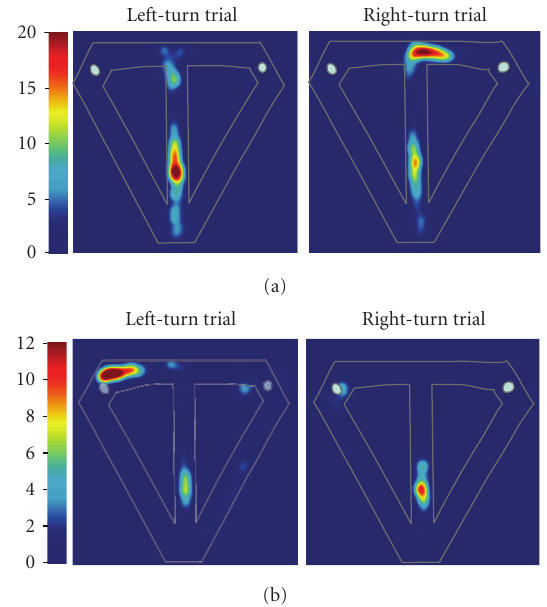
Figure 2: The activity of two example hippocampal neurons represented as false-color rate maps to illustrate di ff erential firing on left- versus right-turn trials. (a). This unit was significantly more active on left-turn trials: significant main e ff ect of segment ( F 6,420 = 91 . 05; P < . 00001) and interaction ( F 6,420 = 2 . 58; P < . 02); log-likelihood ratio = 0.2; p correct = 0 . 6; p chance = 0 . 08. (b). This unit was significantly more active on right-turn trials: significant main e ff ect of segment F 6,252 = 68 . 3; P < . 00001) and interaction F = 2 . 92; P = 0 . 009); log-likelihood ratio = 1.22; p 6,252 p = 0 . 07. Color bars indicate firing rate in Hz. chance